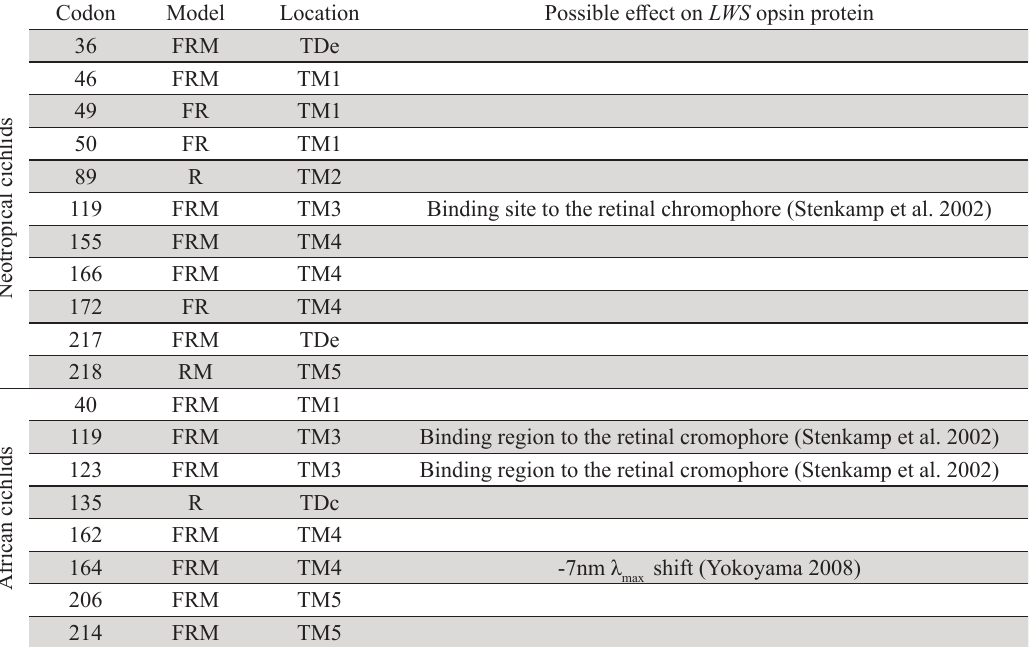
Codons under positive selection and its position in the structure of the LWS opsin protein according to FUbar (F), reL (r) and m8 beb model